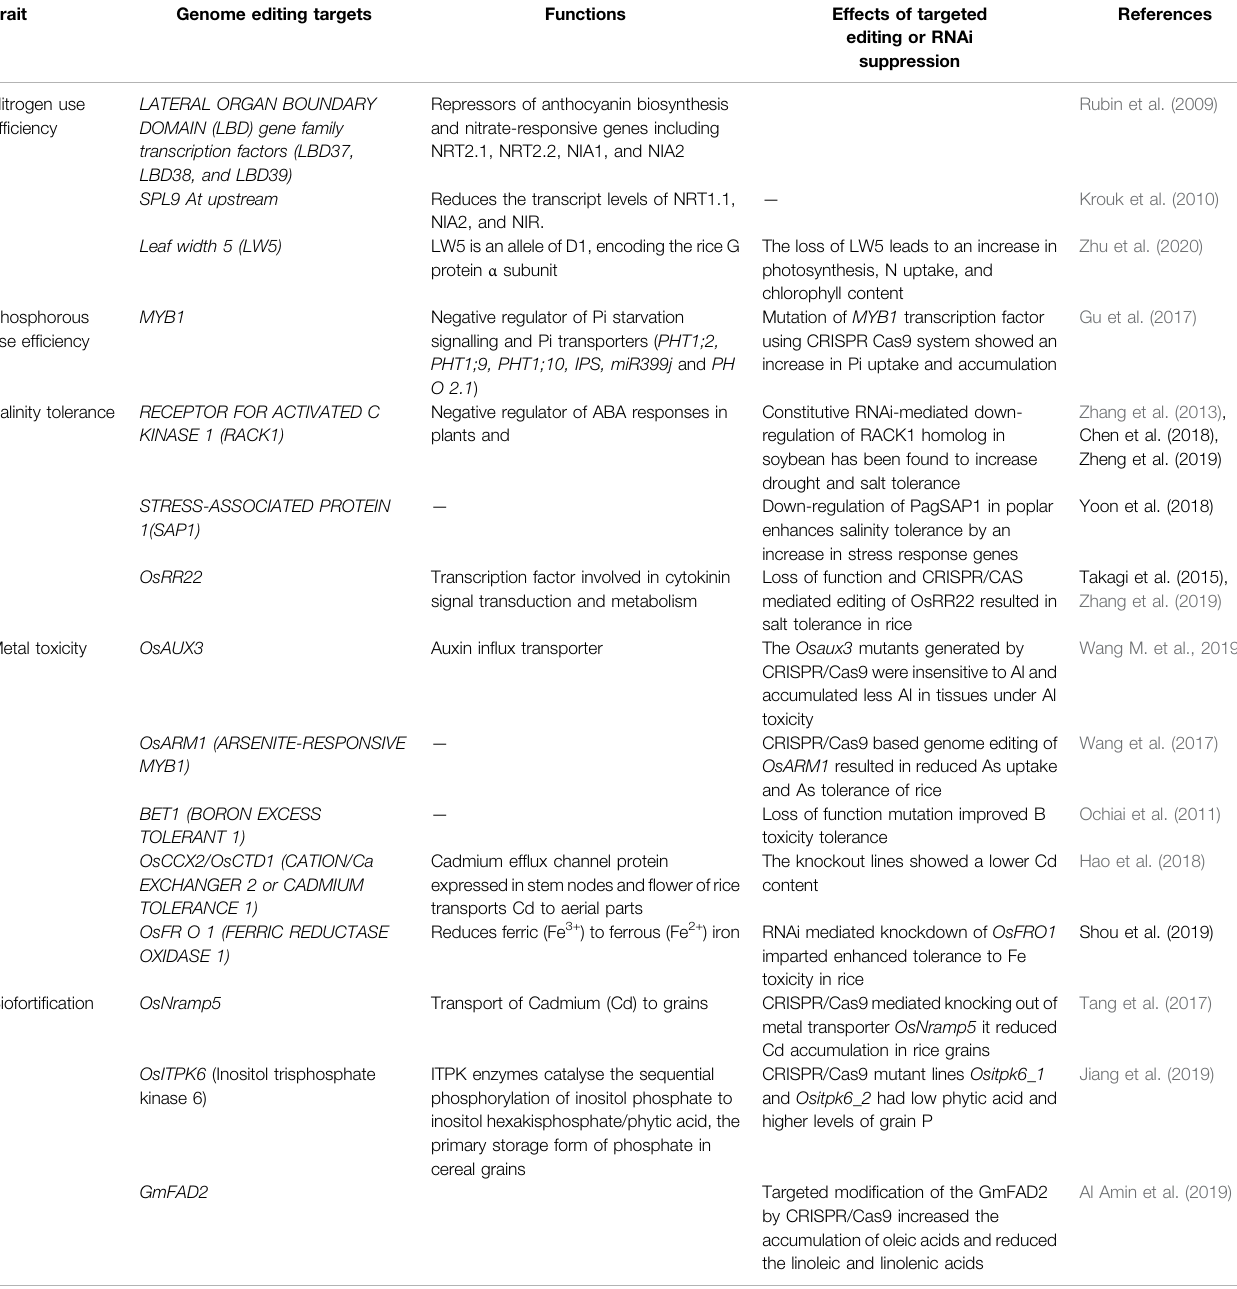
TABLE 1 | Compilation of genome editing case studies and targets for improving nutrient response and toxicity